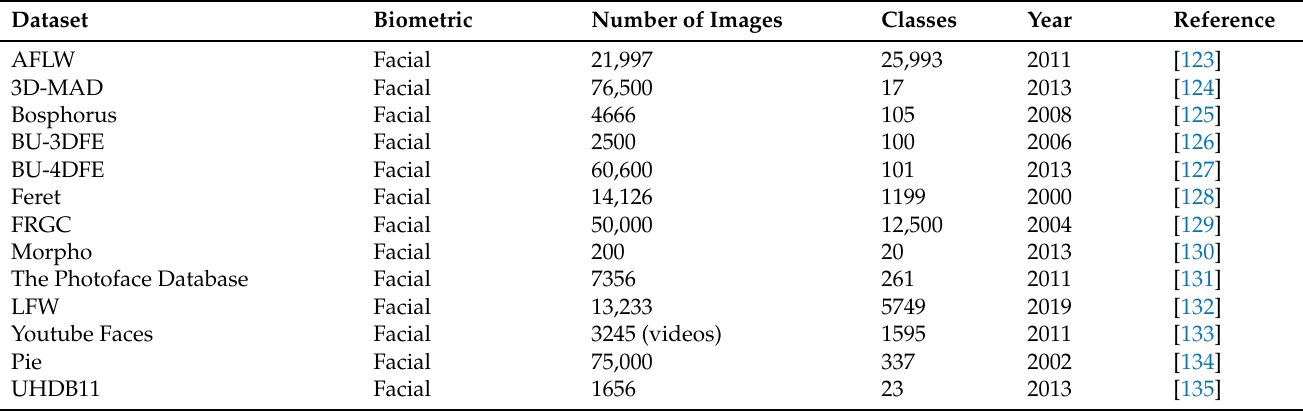
Table 2. Three-Dimensional (3D) Biometrics Dataset